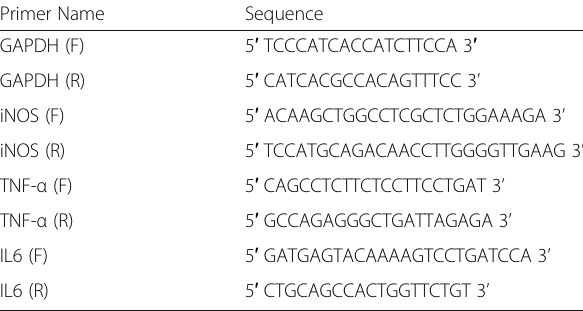
Table 1 Sequences of primers used for